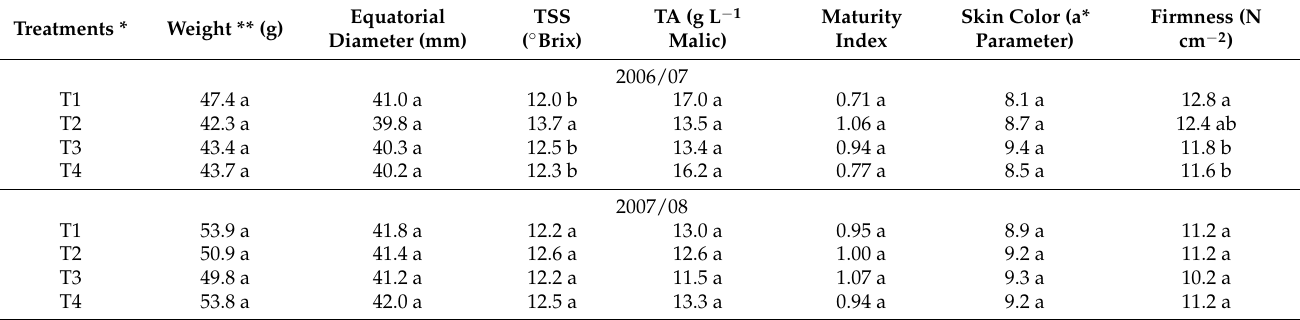
Table 4. Effects of deficit irrigation treatments on fruit quality parameters. TSS: Total Soluble Solid; Ta: Titratable Acidity. Equatorial TSS Treatments * Weight ** (g) Diameter (mm) ( ◦ Brix)